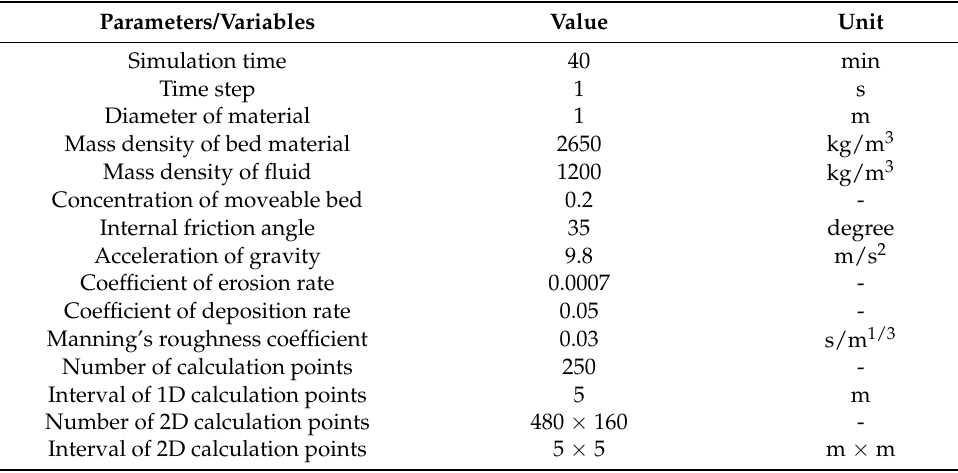
Table 3. The calibrated parameters in the “DEM, Dams, and Observation” tab.